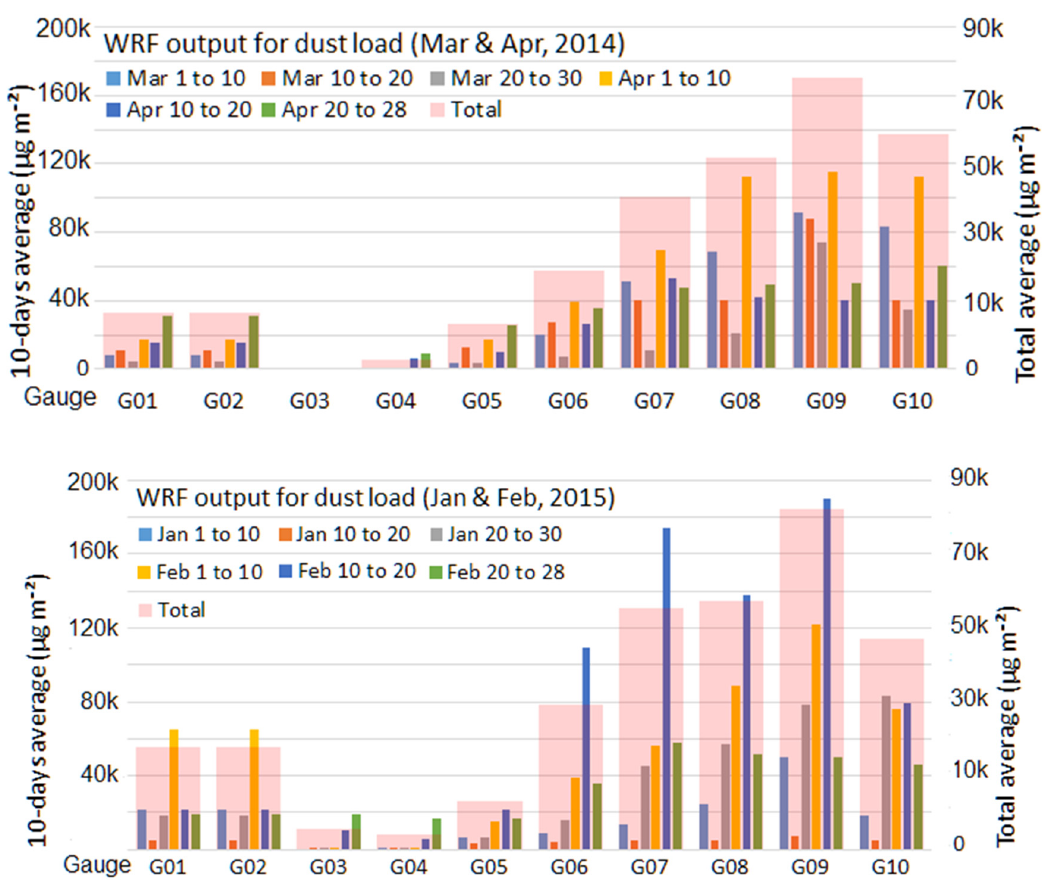
Figure 12. Time series of the 10-day average and total average modeled load ( µ g m − 2 ). The time series plot of the modeled dust load is extracted from the WRF outputs using the nearest point method. The main Y-axis (left) represents the ten-day average values, whereas the secondary Y-axis (right) denotes the total average values